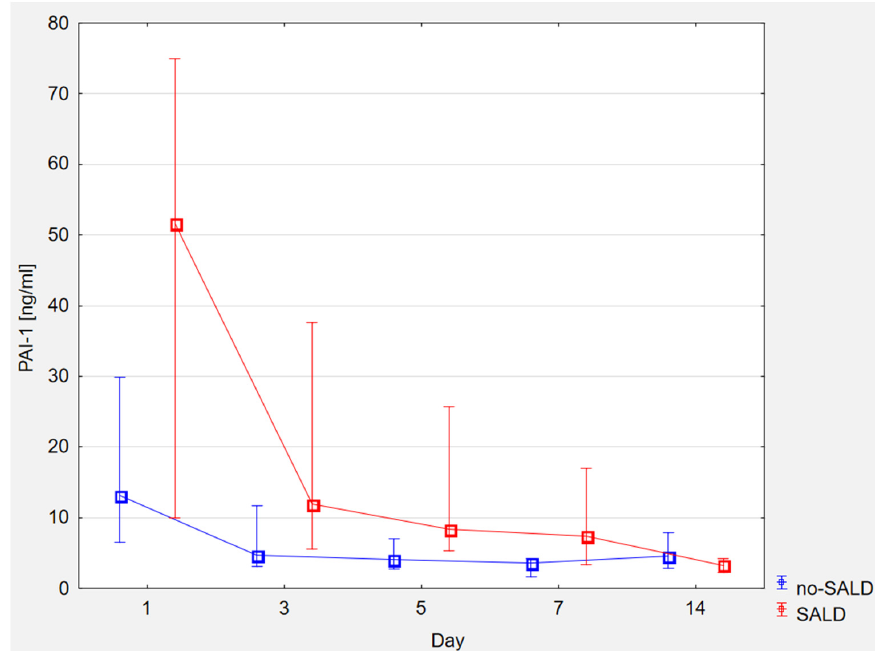
Figure 2. Time course of PAI-1 levels in the SALD and no-SALD groups.